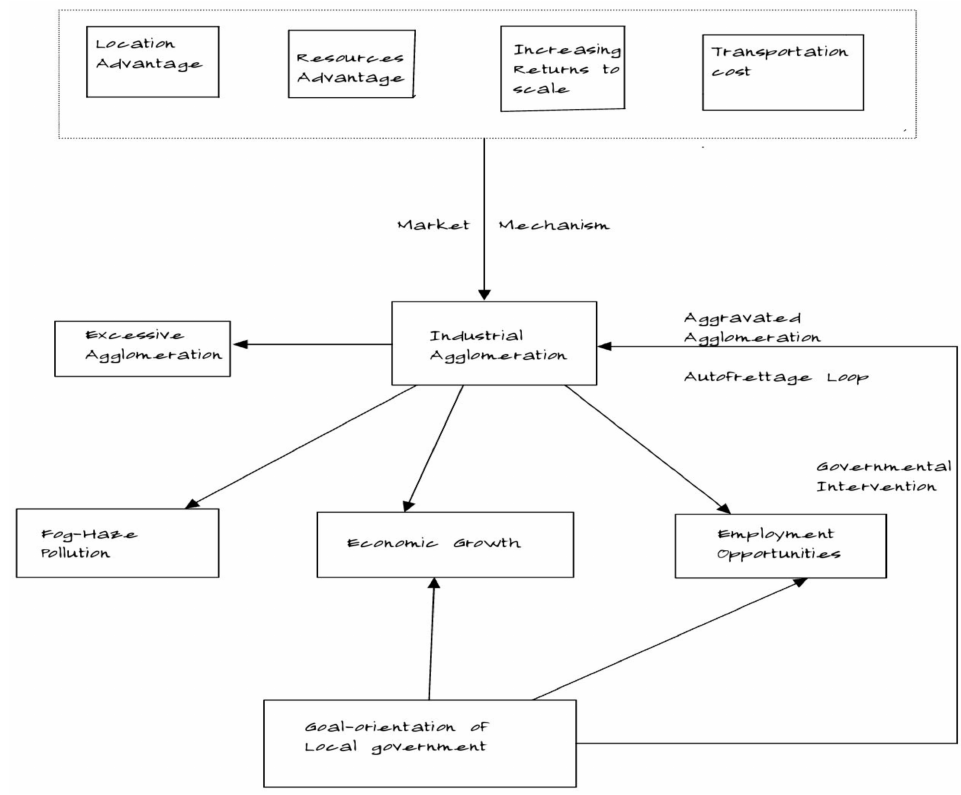
Figure 2. Mechanism analysis of the relationship between industrial agglomeration, economic growth, and haze